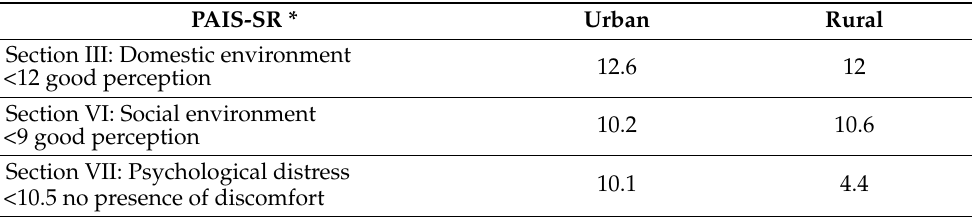
Table 4. Mean scores for Sections III, VI and VII of the PAIS-SR by place of residence. * The maximum score on the PAIS-SR is 24 points for Section III, 18 points for Section VI and 21 points for Section VII. Lower scores indicate better psychosocial adjustment, and higher scores indicate poorer psychosocial adjustment. Source: own elaboration.